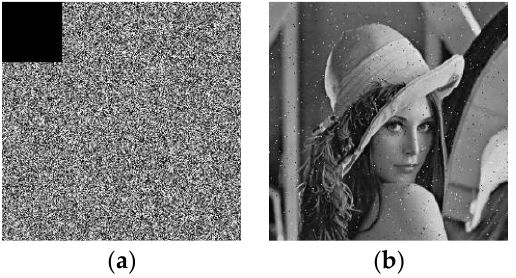
Figure 15. The removal of a 64 × 64 sub block: ( a ) encrypted image and ( b ) decrypted image.